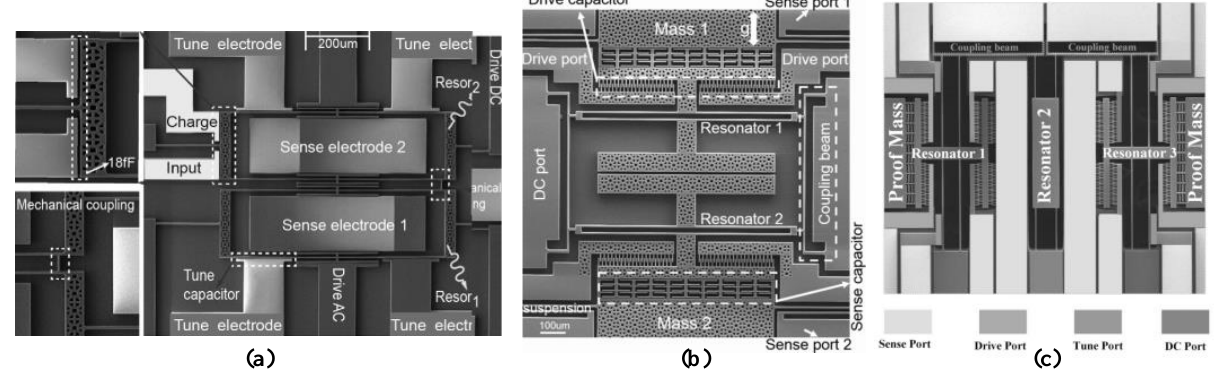
Figure 10. SEM image of two resonators weakly coupled ME-SCRB sensor: ( a ) electrometer; Reproduced with permission from [63]. Copyright © 2016, IEEE. ( b ) accelerometer; Reproduced with permission from [64]. Copyright © 2015, IEEE. ( c ) three resonators weakly coupled ME-SCRB sensor for acceleration measurement. Reproduced with permission from [66]. Copyright © 2018, IEEE.